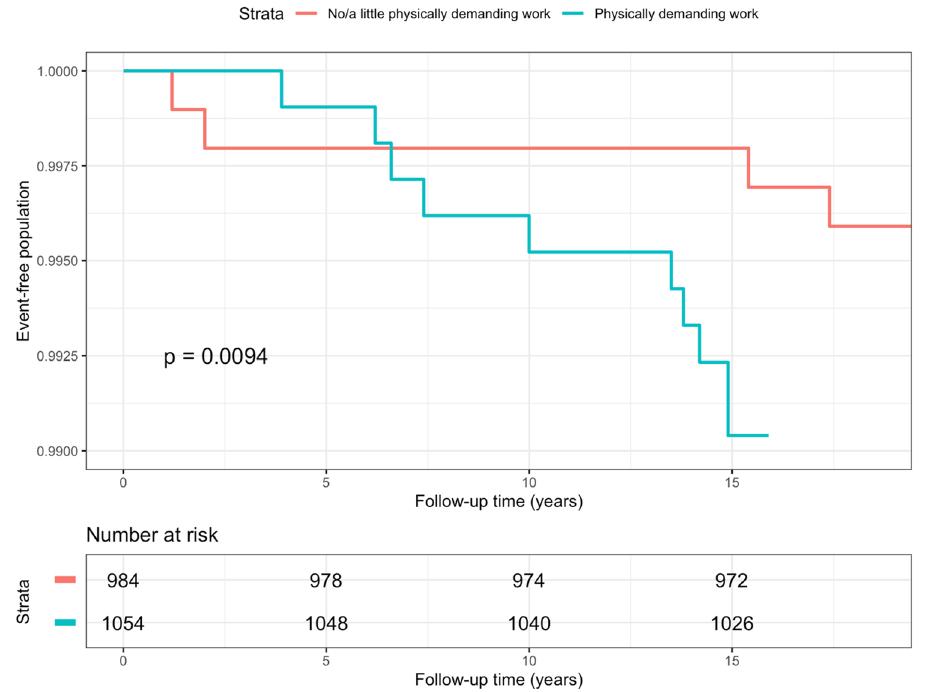
Figure 3. Kaplan–Meier curve of hospitalization for ulnar nerve entrapment among men in the subsample in follow-up 1997– 2018, stratified by physically demanding work at baseline. P-value for log-rank test.